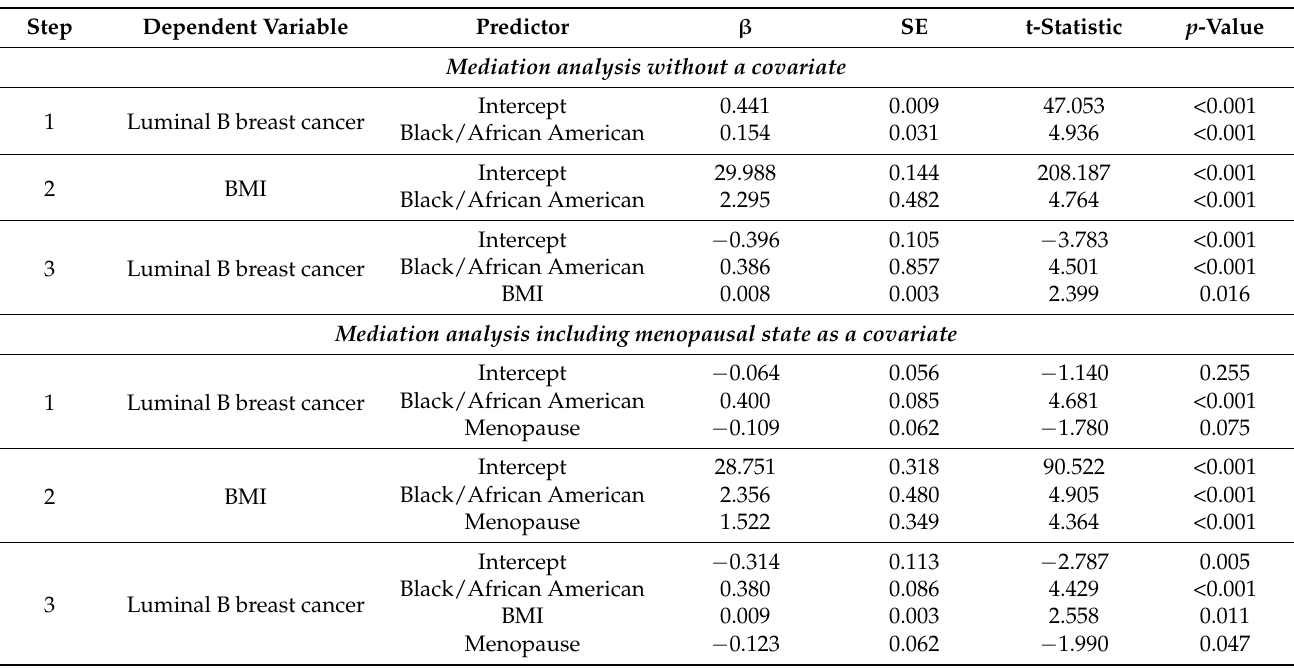
Table 3. Results of mediation analyses examining whether association between Black/African American and Luminal B breast carcinoma is mediated by